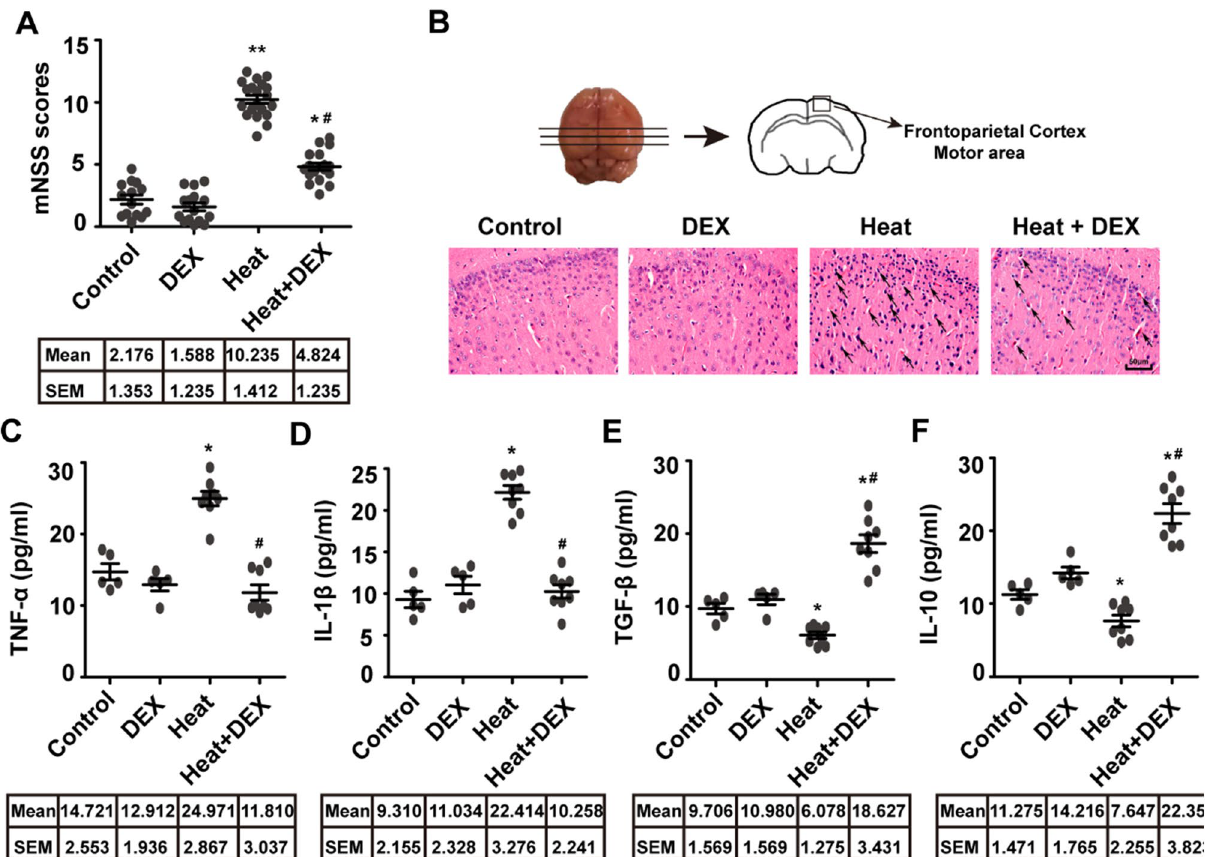
Figure 1. DEX reduces the nerve damage and neuroinflammation caused by heatstroke. ICR mice were exposed to an ambient temperature of 41 ± 0.5 °C until Tc > 42.7 °C (heatstroke onset), and then injected intraperitoneally with 25 µg/kg DEX (Heat + DEX group) or 0.9% saline (Heat group), followed by a 12-h recovery at an ambient temperature of 23 ± 1 °C. ( A ) The neurological function of mice was evaluated by the modified neurological severity score (mNSS). ( B ) Representative pathological pictures of brain sections stained with haematoxylin-eosin (HE) at a magnification of X-200. ( C – F ) Cytokine expression levels in the cerebral cortex were assessed by ELISA. The data are shown as the mean ± SEM of three independent experiments. Statistical analysis: two-way ANOVA. * p < 0.05, ** p < 0.001 vs. Control. # p < 0.05 vs.